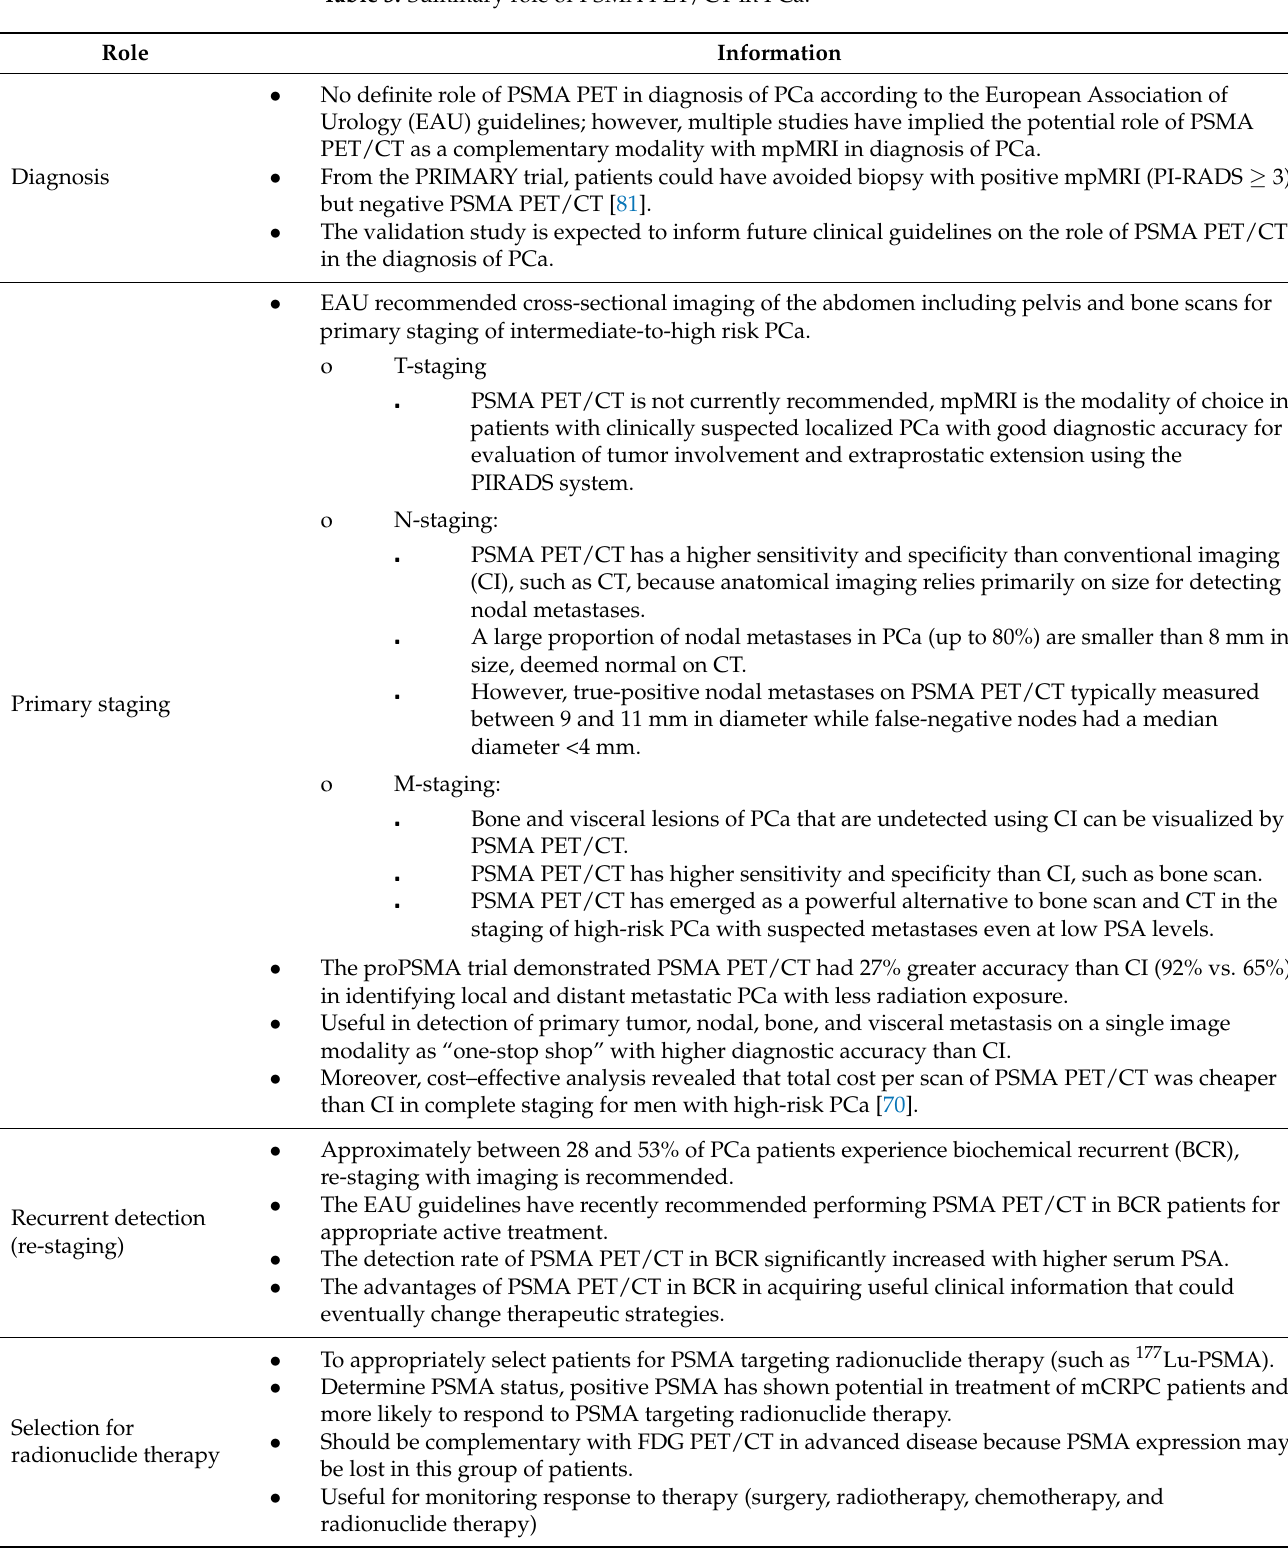
Table 3. Summary role of PSMA PET/CT in